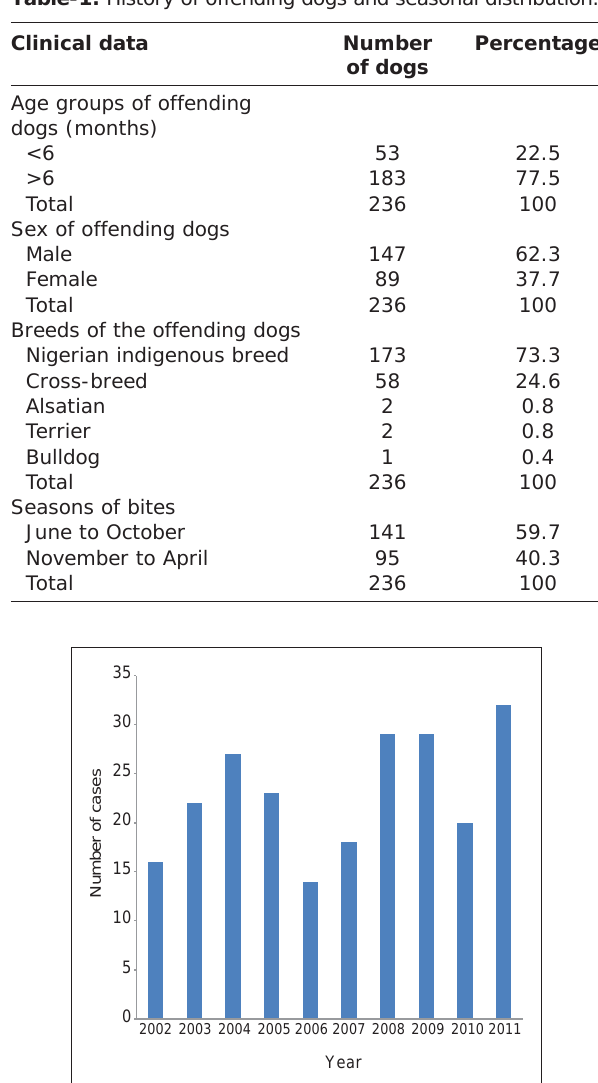
Table-1: History of offending dogs and seasonal distribution.